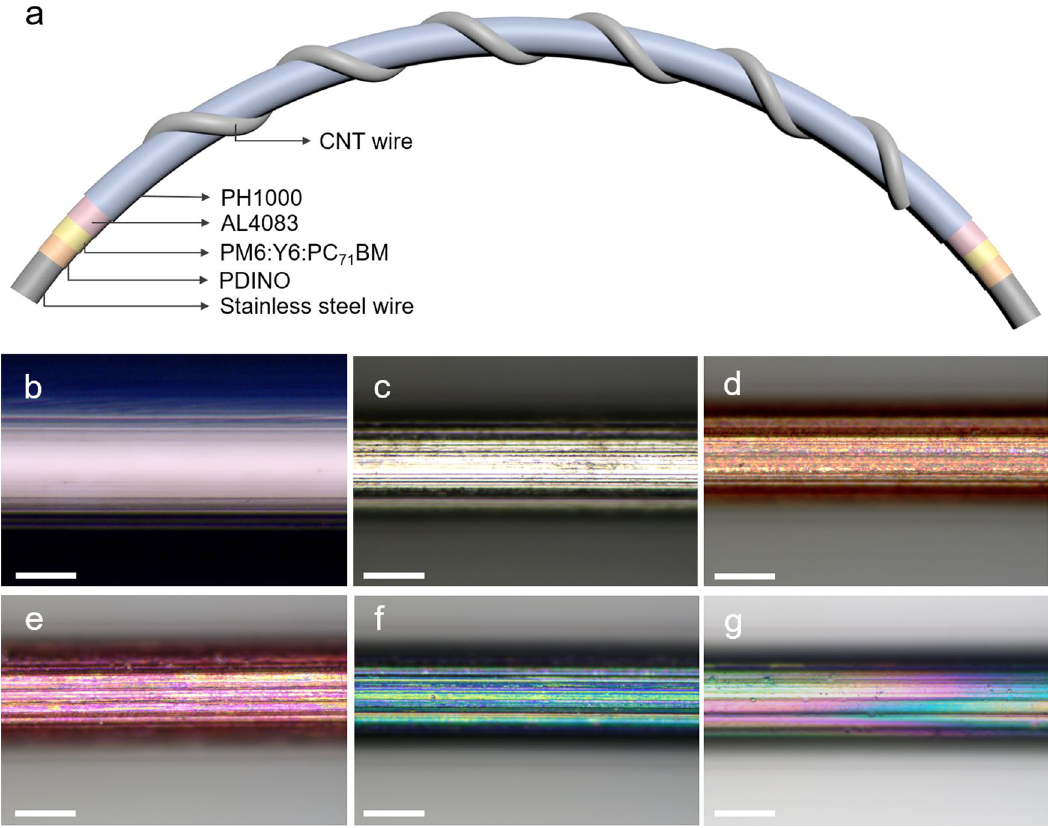
Fig. 1 Depiction of the FOSCs with architecture schematic and optical microscopic images. a Illustration of the fi ber-shaped organic solar cell (FOSC). Optical micrographs of b lab-grade stainless-steel wire ( ∅ = 0.127 mm); c primary industry-grade stainless-steel wire electrode ( ∅ μ = 0.10 mm); d PDINO ETL; e PM6:Y6:PC 71 BM active layer; f AL4083 layer; and g PH1000 layer. The scale bar is 50